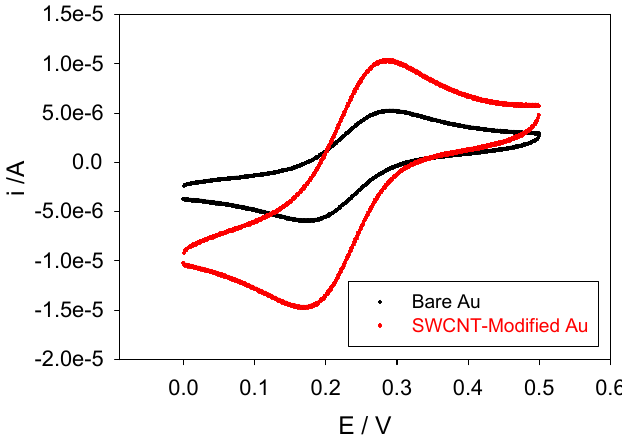
Figure 3. Comparison between voltammograms obtained using a bare and SWCNT-modified gold working electrode. The scan rate employed was 100 mVs -1 . The electrolyte used was 1mM potassium ferricyanide in 50 mM KCl in 50 mM phosphate buffer (pH